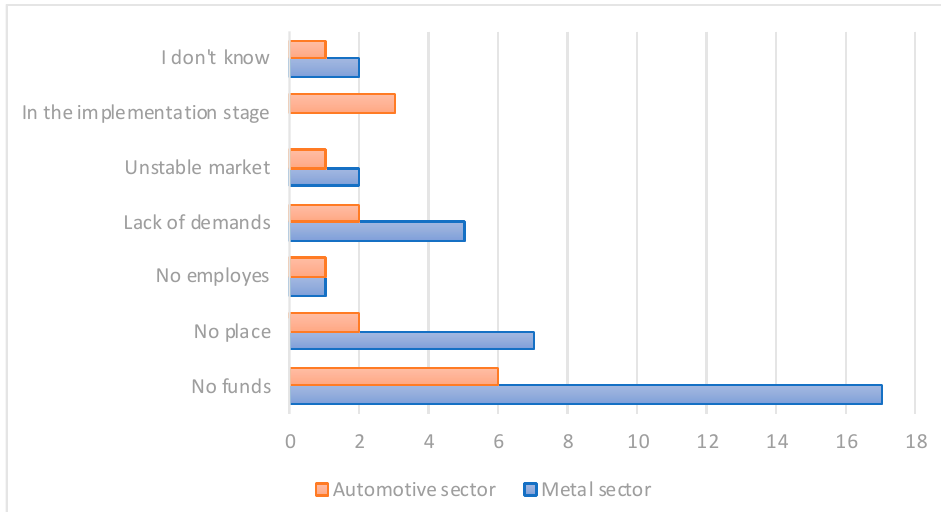
Figure 5. Restrictions affecting the decision to implement AM in the metal and automotive industry manufacturing companies surveyed.